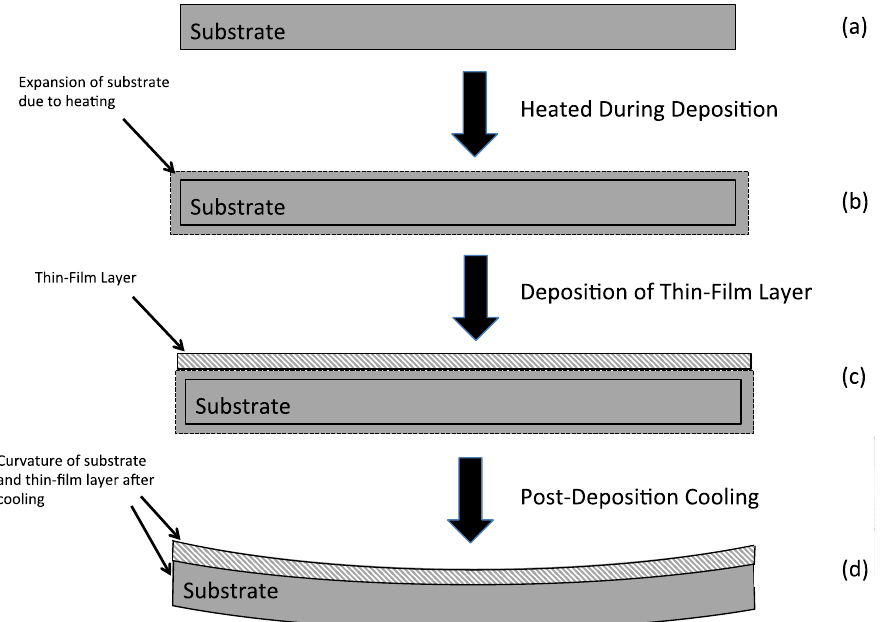
Figure 1. An illustration of residual stresses in thin-film layers deposited onto substrates. In this case, the thin film material layer would be in a state of tensile stress (with a positive sign).